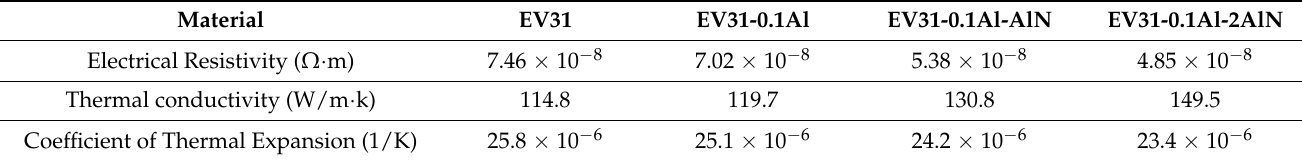
Table 2. Electrical and thermophysical properties of EV31, modified EV31 and its corresponding